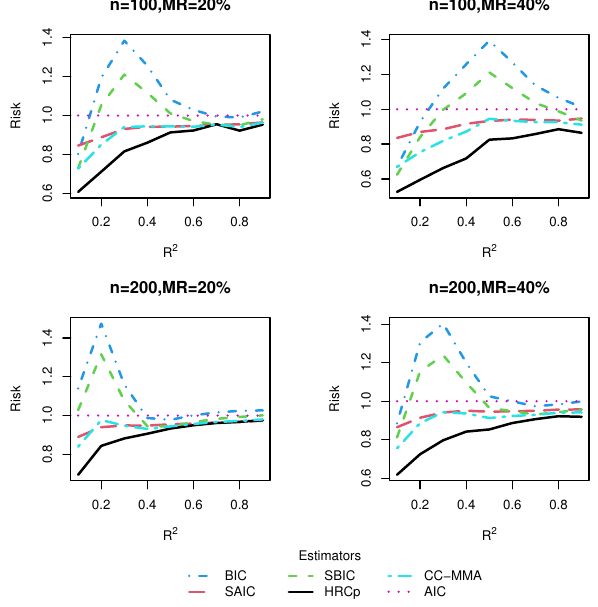
Figure 3. Risk comparisons for Design 1.